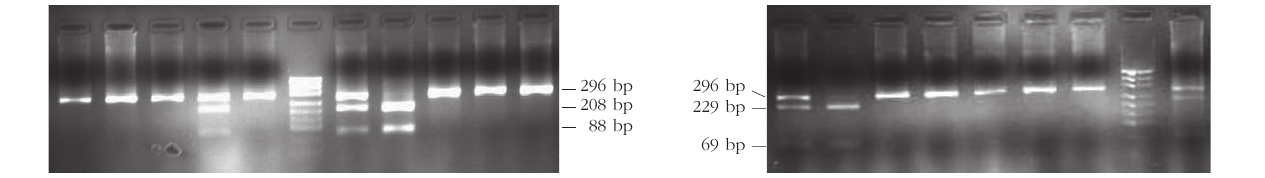
Fig 2 – Electrophoretic patterns of the second exon of Ovar- DRB 1 digested with Sac I in Kazakh sheep, M: puc19 DNA marker.